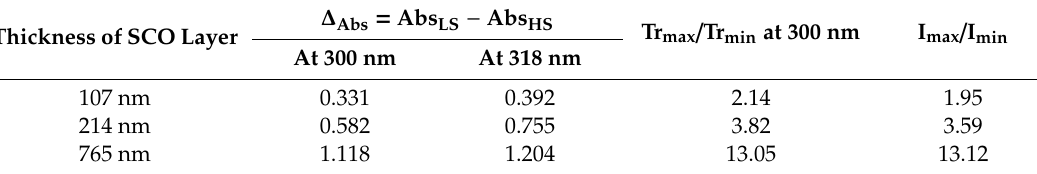
Table 1. Comparison of the UV absorption and luminescent properties of bilayer films with di ff erent thickness of SCO layers.